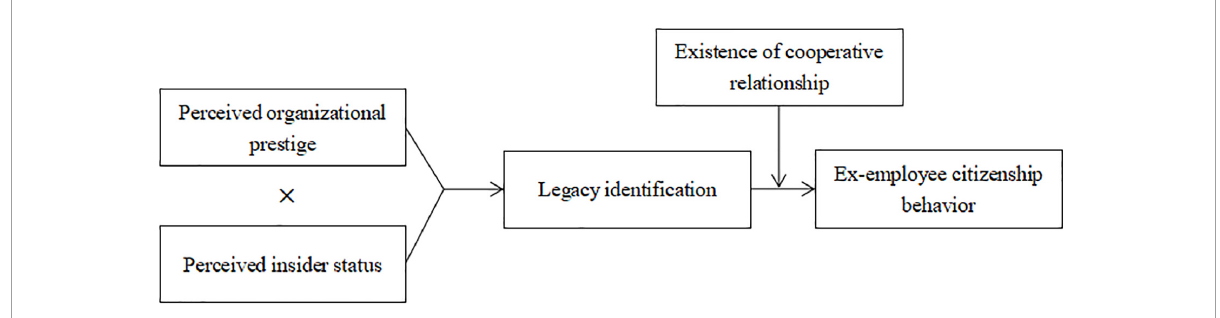
FIGURE1 Hypothesized research